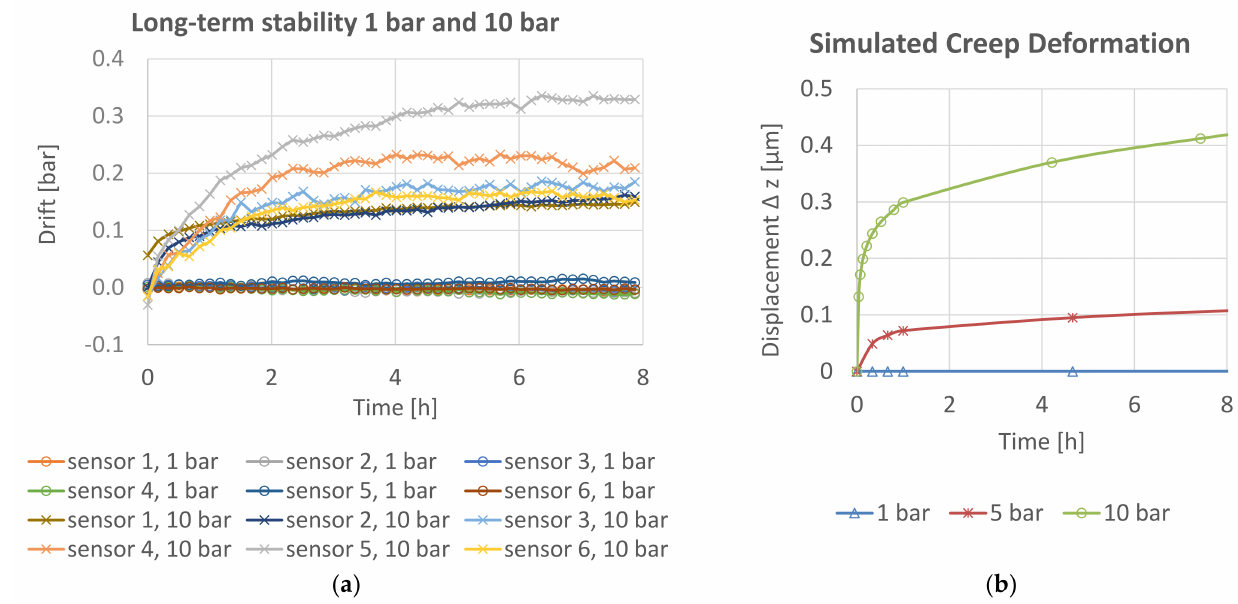
Figure 4. ( a ) Measured long-term drift of sensors with SAC305 soldered membrane at 1 bar and at 10 bars at room temperature; ( b ) simulated creep deformation for SAC305 solder at 20 ◦